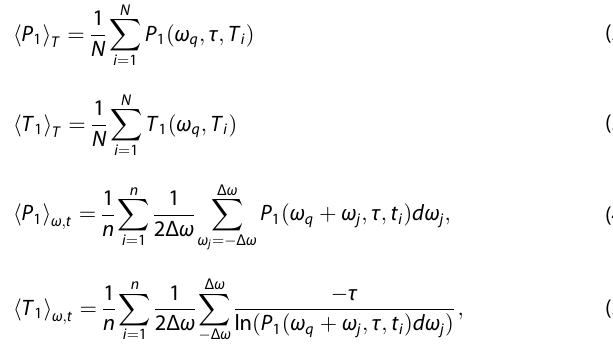
where d is the number of qubits in the device or analysis, 10 in this case, and X is the observable P 1 or T 1 . The Pearson correlation is a normalized covariance between two variables re fl ecting a linear correlation from 1 to − 1, where R = 1 ( − 1) represents a 100% positive (negative) correlation and R = 0 indicates no correlation. Strong R correlation can therefore signal the existence of a potential linear mapping between the estimator and h T 1 i , in T particular, possibly one that is 1:1 or a scaling factor that will reliably estimate h T 1 i . T For a single frequency sweep that takes ~20 min, we obtain 0.76 < R ( t i ) < 0.84 correlation between h T 1 i and h T 1 i ω ; for T t 0.5 MHz < Δ ω < 5 MHz. Using the P 1 values without assuming an exponential dependence leads to stronger correlations of 0.87 < R ( t i ) < 0.91. Both of these are substantially stronger than the correlation found between the representative instance of T 1 and h T 1 i , which was R = 0.29. We note this instance of R can have T a large spread, as seen by simulations of Gaussian-distributed fl uctuations in supplemental information S4. A better estimate of the h T 1 i for each qubit, Q k , in the device T can be obtained from a moving average of multiple, N , measure- ments. We show the evolution of h R i using a moving average of T 0 ! N the T 1 ( T i ) measurements, h T 1 i , for each qubit, Fig. 5b. The T 0 ! N h R i exceeds R ~ 0.8 (i.e., strong correlation) after ~10 measure- T 0 ! N ments, corresponding to a time exceeding 100 h. Approximately 10 independent measurements is suf fi cient for fl uctuations with magnitude (cid:3) 0 : 2 h T 1 i to obtain a strong correlation, R ~ 0.8, T between an estimator (e.g., h T 1 i ) and h T 1 i . The details of R T 0 ! N T dependence on fl uctuation magnitude and number of measure- ments in the moving average are discussed more completely in supplemental information S4. Autocorrelation between T 1 ( T i ) and T 1 ( T i − 1 ) measurements is an underlying challenge to fast estimation of h T 1 i . Evidence of T autocorrelation can be seen for example in long-term drifts in the average and short-term correlations between T 1 , inset of Fig. 5b. On shorter time scales, our experimental data shows evidence of stronger autocorrelation frustrating faster accurate estimation of h T 1 i and T that the fastest R ~ 0.8 can be obtained on order of 1 – 2 days, see supplemental information S5 and S6. We conclude that h T 1 i ω ; shows t promise as a method for faster estimation of h T 1 i than repeated T T 1 ( ω = ω q ) measurements at only the qubit frequency. Extending the h T i ω ; t estimator to a set of many qubits, { Q k }, in a device result in 1 larger R, in the same time, compared to relying only on T 1 ( ω q ) measurements for each qubit. The R value simply being a quantitative single value expression of the high correlation between each h T 1 i ω ; t and h T 1 i across the entire set of qubits. T